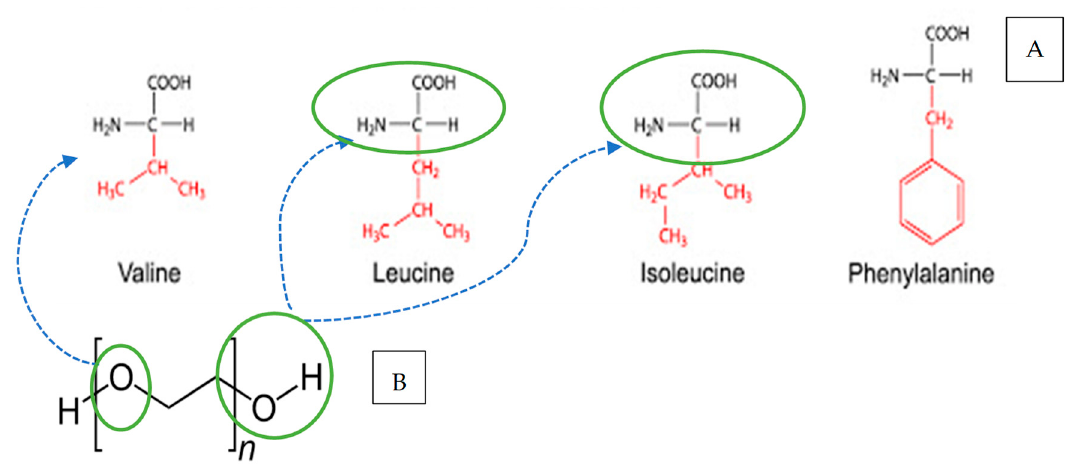
Figure 9. Chemical structures of some of the essential amino acids present in ( A ) MOLP and ( B ) general chemical structure of polyethylene glycol showing potential positions of hydrogen bonding between the components.